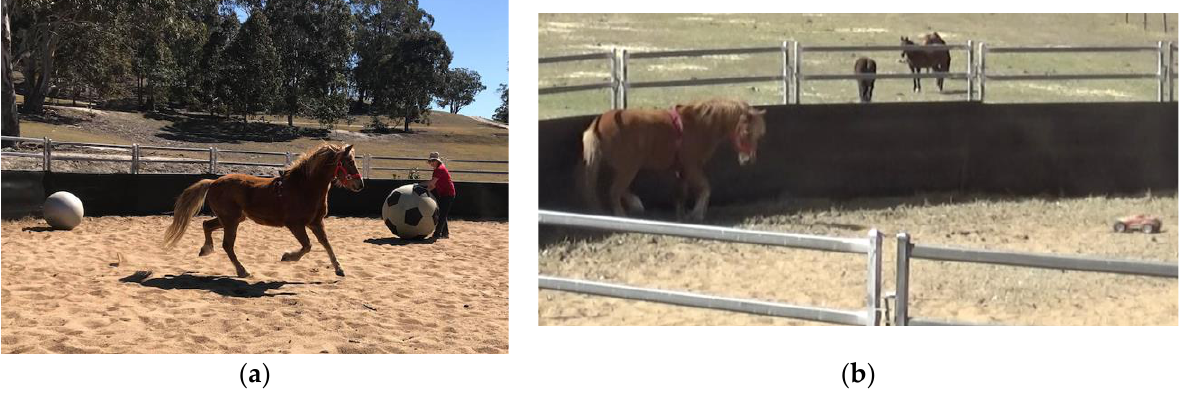
Figure 2. ( a ). Novel object stress treatment. ( b ). Multi-modal stress treatment-radio controlled car.